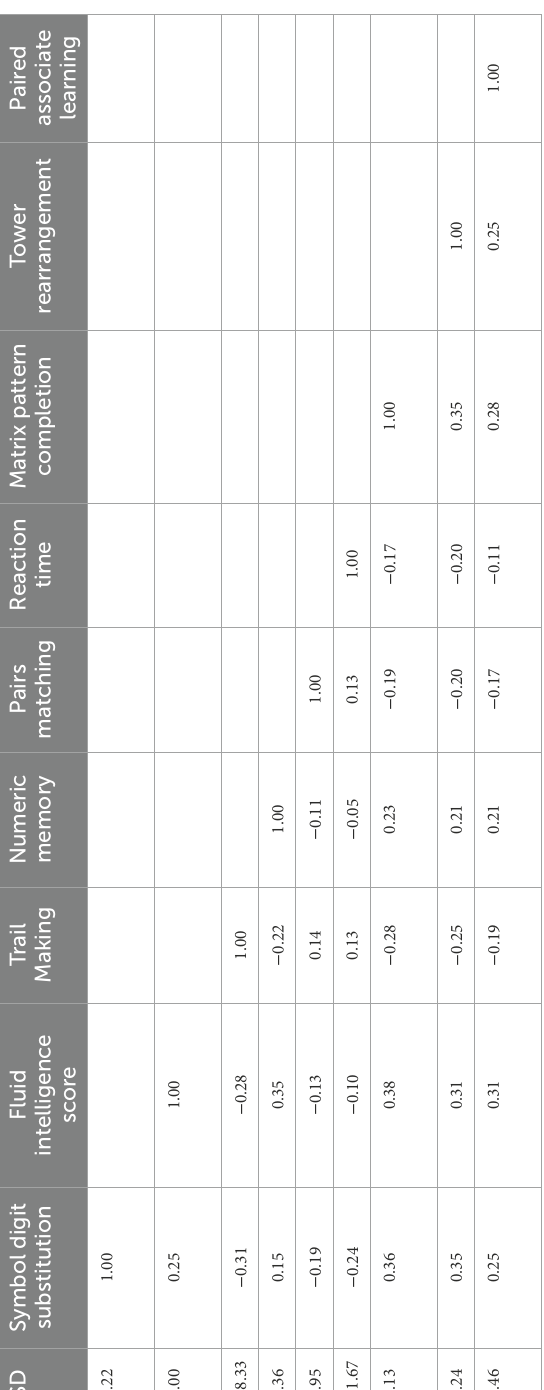
The solid blue line in the top part is based on the extraction of principal components (PCA) and solid line in the bottom part is based on factor analysis (FA, diagonal values in the matrix of number of eigenvalues form PCA that are greater than 1 (horizontal line) in the top panel. This suggests the extraction of two factors. Another criterion is based on parallel analysis. Dotted red lines in Figure 1 represent the plot of the eigenvalues based on simulated data. The number of factors to be extracted is indicated by the crossover of the two (solid and dotted) lines. Each point on the solid blue line that lies above the corresponding simulated data line is a factor or